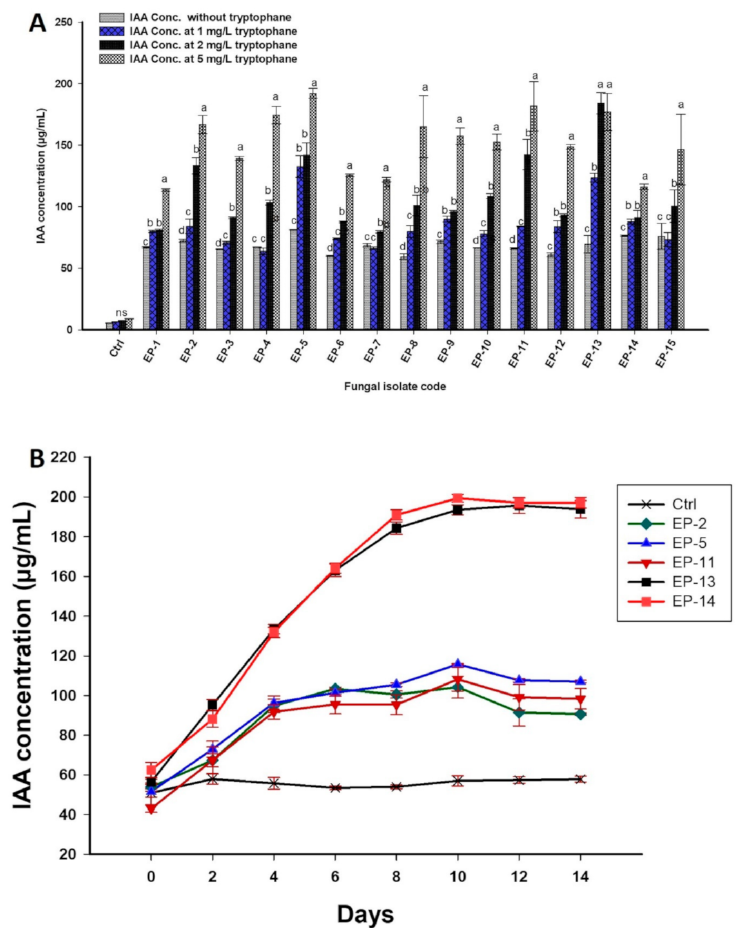
Figure 2. ( A ) Quantitative production of IAA by 15 endophytic fungal strains in the absence/presence of different concentrations of tryptophan (1.0, 2.0, and 5.0 mg/L) after 7 days of incubation. ( B ) IAA production by the most potent five fungal strains in the presence of 5 mg/mL tryptophan and over 14 days. Ctrl, controls without fungal inoculation. Data are statistically different at p ≤ 0.05 by Tukey’s test, ( n = 3); error bars are means ± SE. For each strain, bars with different letters (a, b, c, and d) denote that mean values are significantly different at a significance level of p ≤ 0.05. The standard error is less than the size of symbols if no error bars are